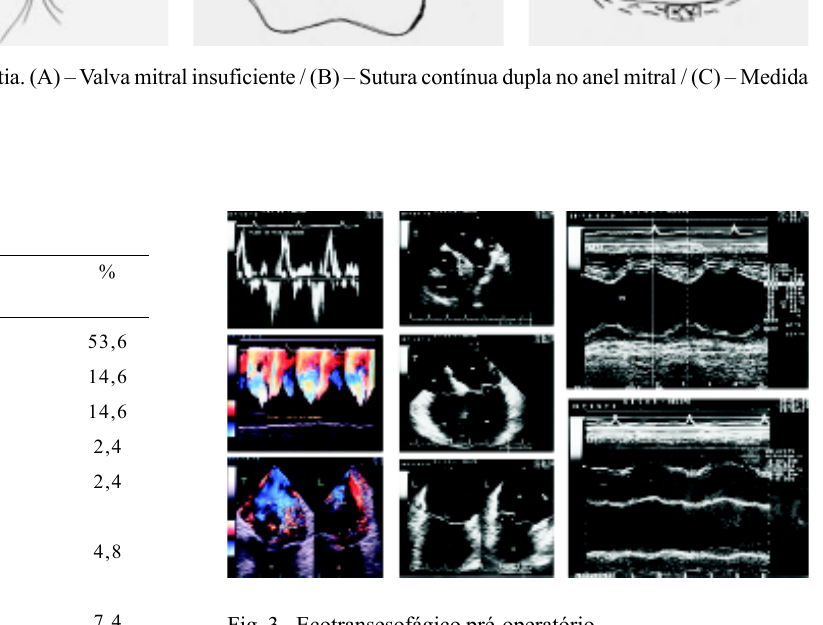
Fig. 3 - Ecotransesofágico